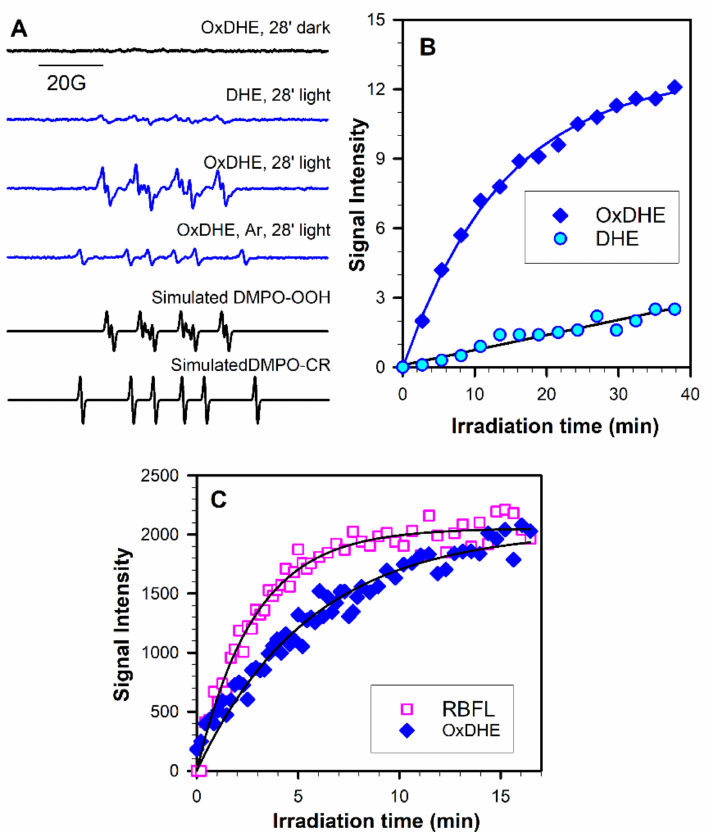
Figure 8. Photoexcitation of oxidised DHE solubilised in dimethylsulphoxide (DMSO) with visible light in the presence of DMPO as the spin trap results in oxygen-dependent accumulation of DMPO- • OOH adducts with a quantum yield 2.8-fold smaller than for riboflavin. ( A ) Representative ESR spectra acquired from samples of lipophilic extracts from liposomes made from oxidised (OxDHE) or freshly opened 16:0-22:6PC (DHE) solubilised in DMSO:benzene (9:1) and exposed to 27 mW/cm 2 visible light in the presence of 0.1 M DMPO inside the resonant cavity of ESR spectrometer. The spectra were acquired after 28 min of light exposure or incubation in the dark. The samples were saturated with air, except for the sample saturated with argon (Ar). Simulated spectra of DMPO- • OOH and DMPO- • CH adducts were created to identify the adducts in the experimental spectra as